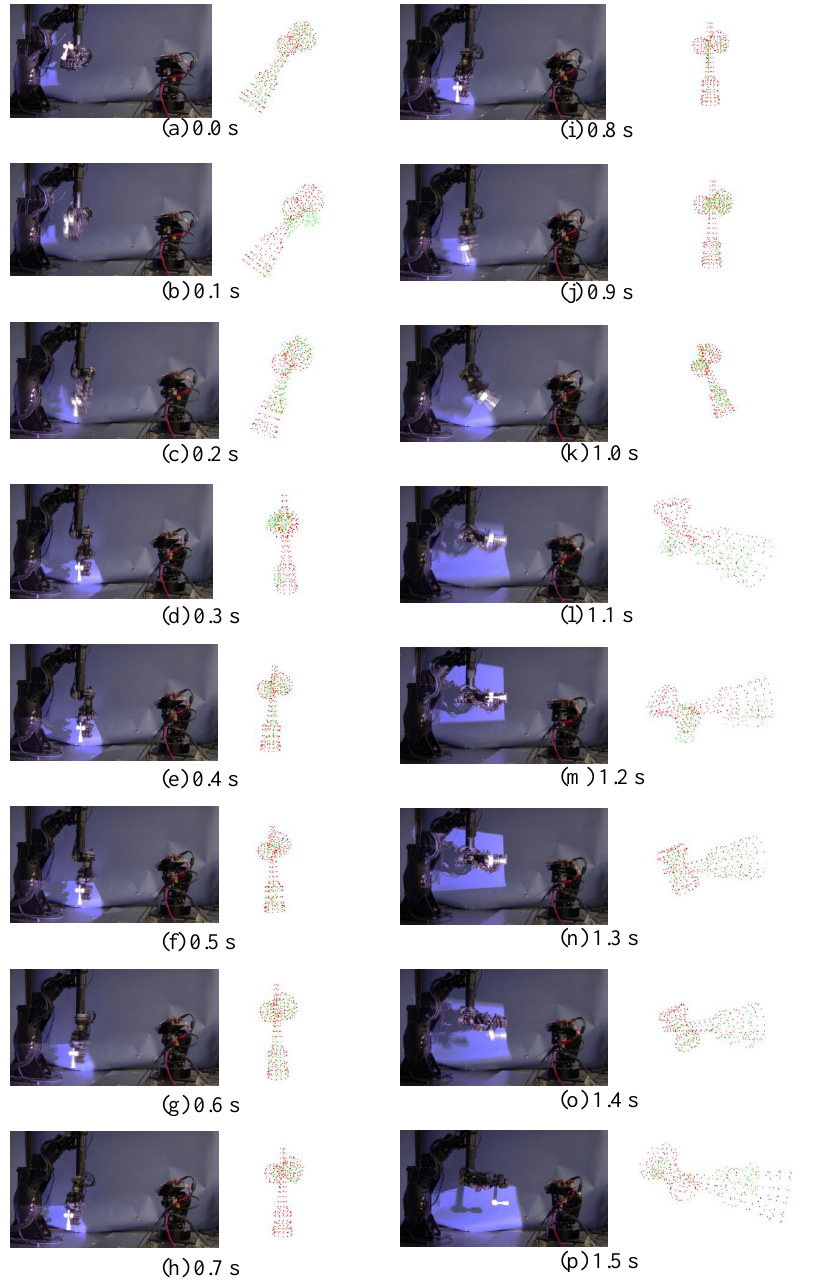
Figure 14. Continuous images of real-time model